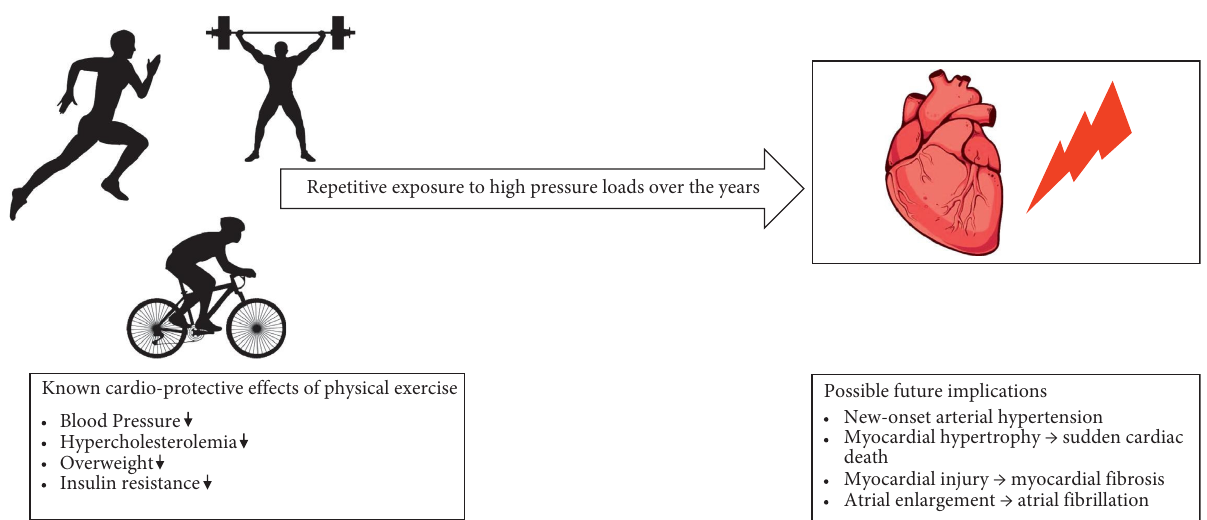
Figure 3: Scheme of possible future implications in athletes with hypertensive response to exercise. Tis fgure illustrates athletes with hypertensive response to exercise and the possible future cardiovascular implications throughout the years. At the beginning, the cardio- protective efects of physical exercise seem to outweigh the negative risk factors associated with HRE. Due to the repetitive pressure overloads during the years, the negative efects could predominately outweigh the